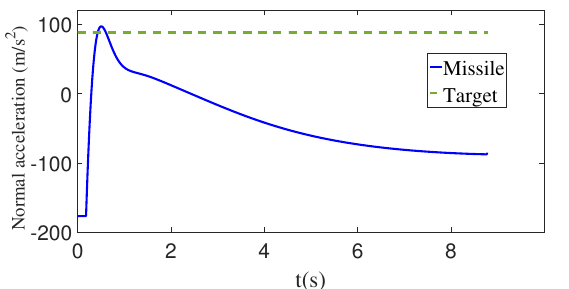
with constant maneuver. α